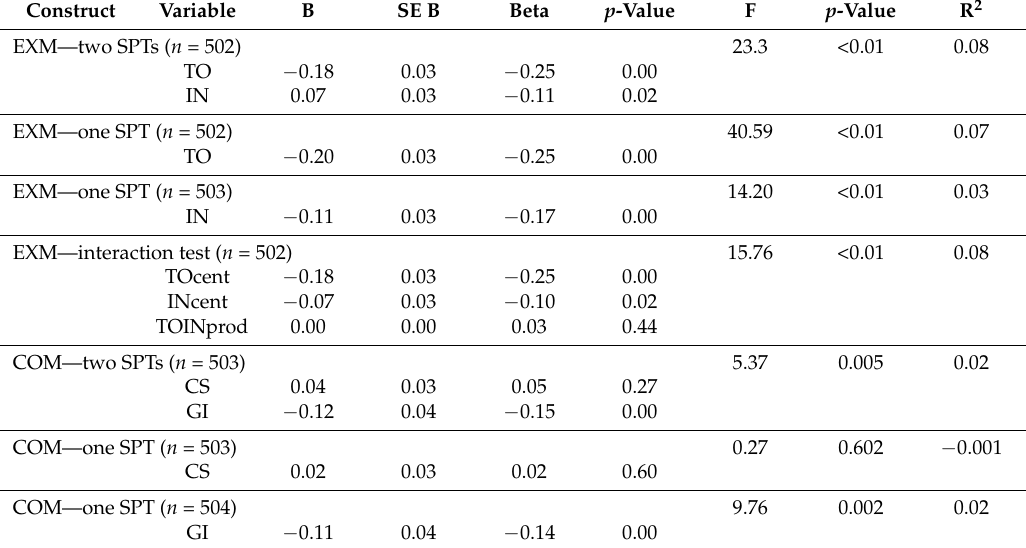
Table 3. Additional Standard Multiple Regression Analyses for Obtained Social Personality Traits Predictors on Religious Doubt